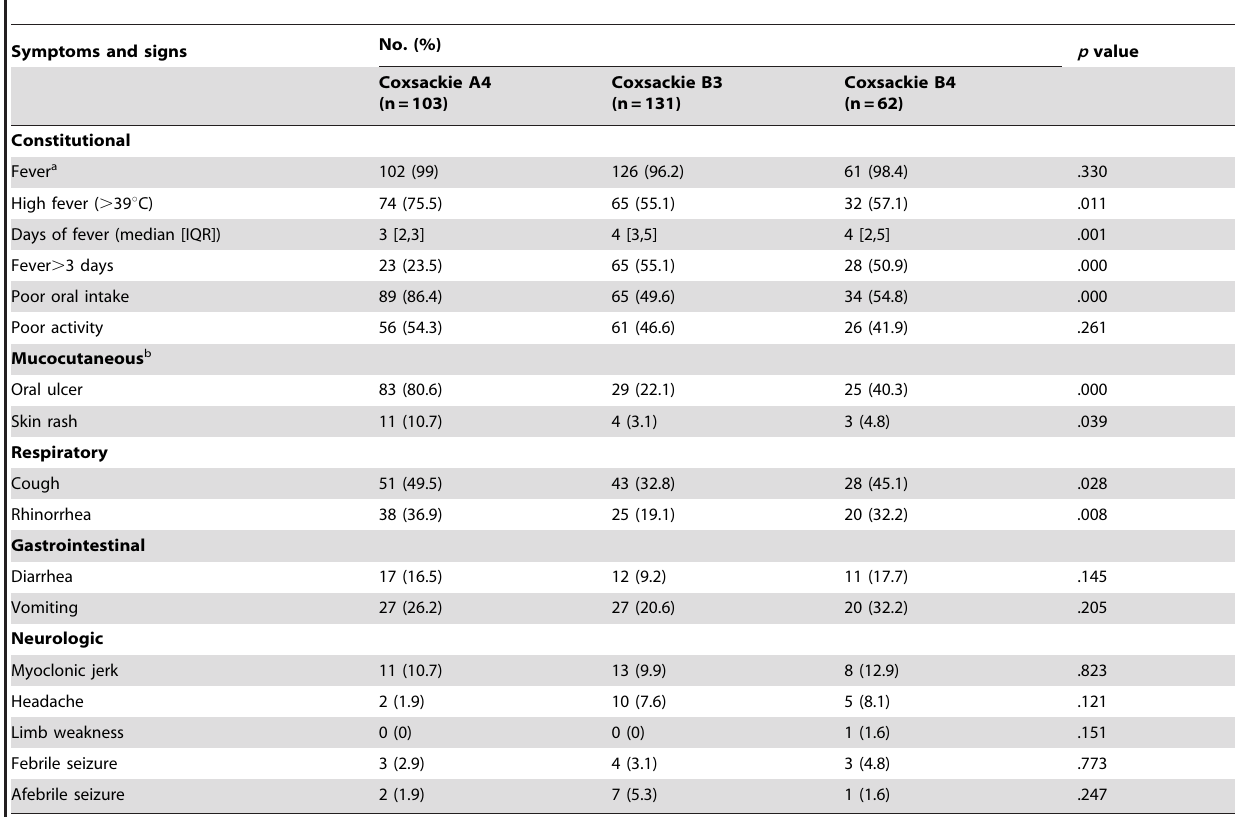
Table 2. Clinical manifestations in 296 hospitalized children with coxsackievirus A4, B3 and B4 infections stratified by serotypes.